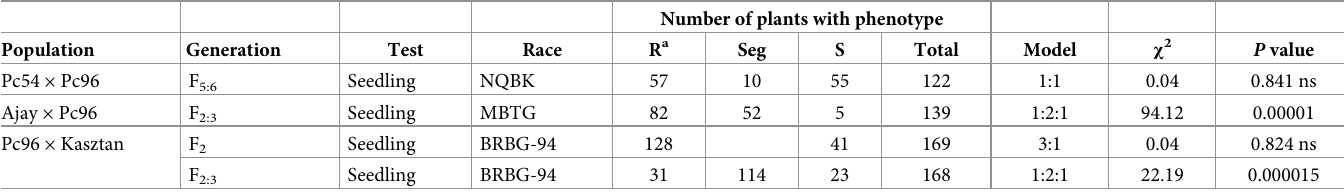
Table 1. Crown rust reaction segregation ratios in three biparental populations.